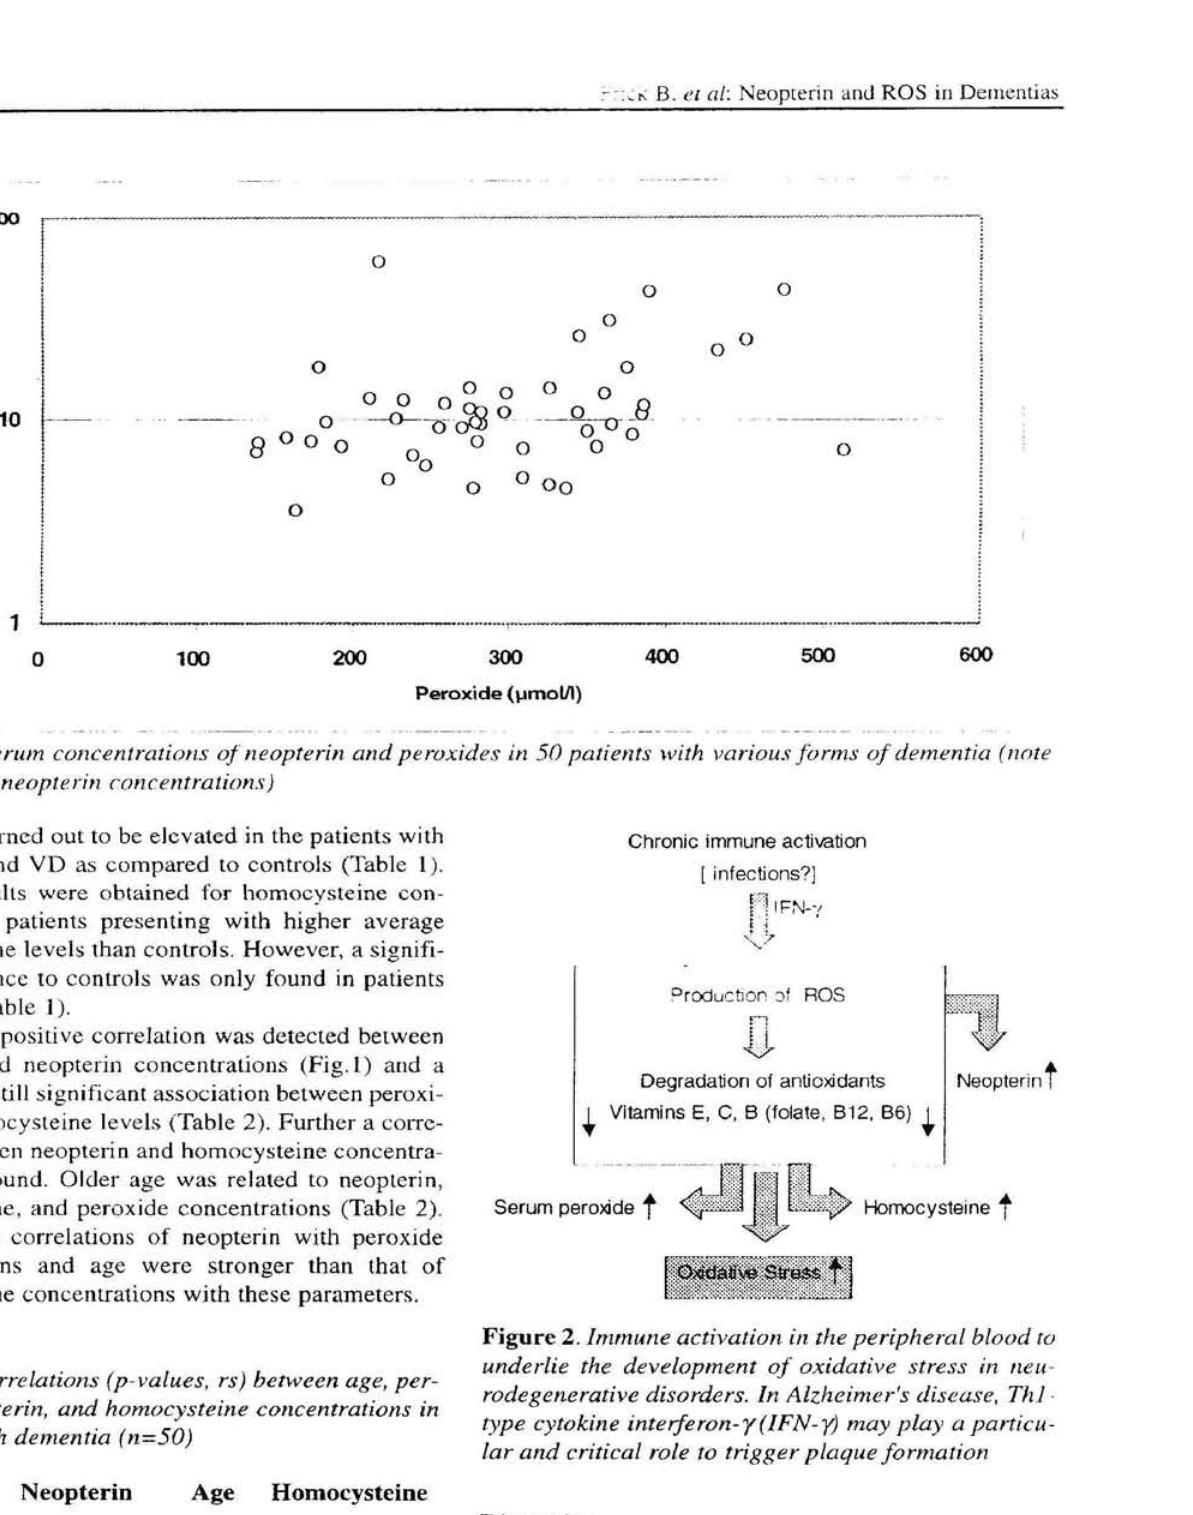
Figure 2. Immune activation in the peripheral blood to